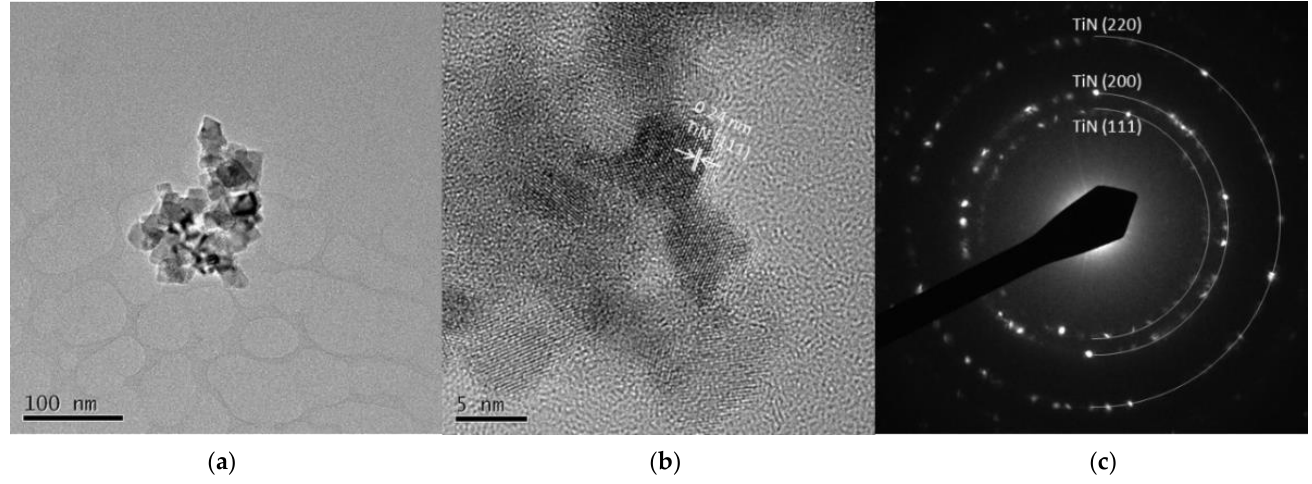
Figure 5. TEM images of Ti 5 A particles ( a ) low resolution image; ( b ) high resolution image; ( c ) SAED pattern.